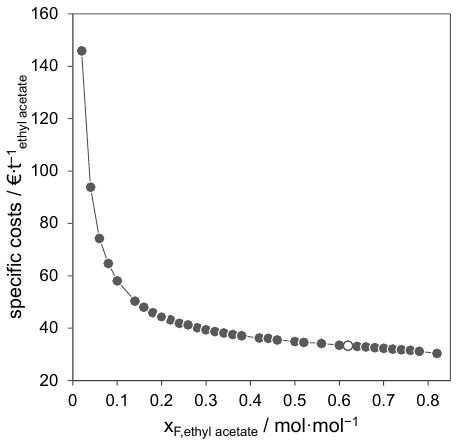
Figure 10. Specific costs of ethyl acetate for variable feed compositions. The white circle indicates the feed composition from Section